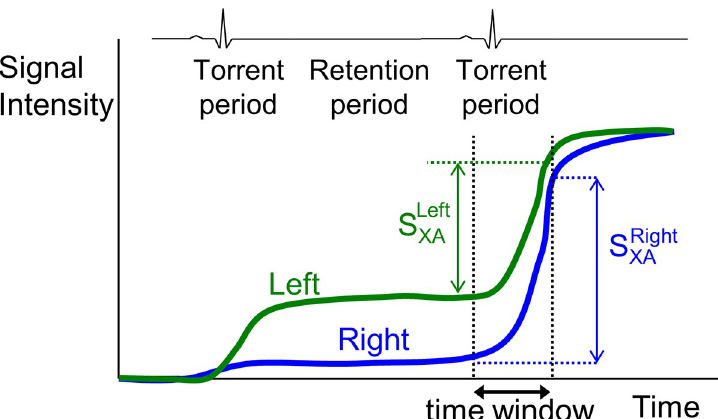
Fig 4. Time-signal intensity curves of contrast agent in each lung field. The time-intensity curve of contrast agent in each lung field over a cardiac cycle is shown. Since the baseline signal intensity of contrast in each lung is different, the net increase in signal intensity of each lung (S XALeft, S XARight ) over a torrent period during the second cardiac cycle after injection is used for calculating the pulmonary blood flow distribution for analysis.